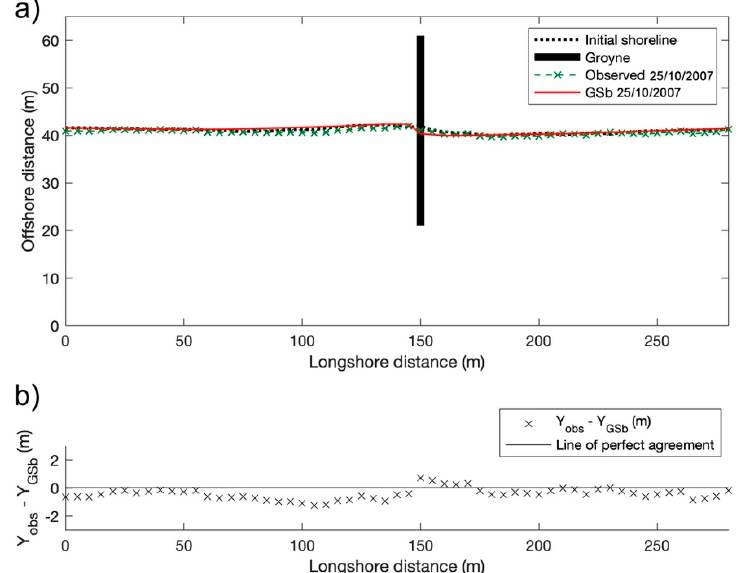
Figure 16. ( a ) Observed and calculated shorelines after 24 days from the groyne deployment. ( b ) Difference Y obs –Y GSb .